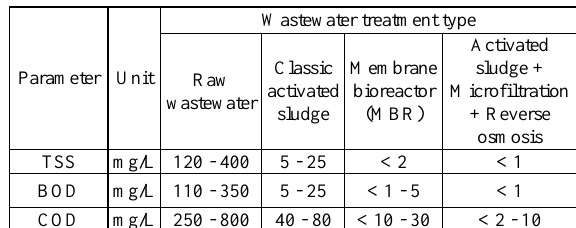
Table 5. Discharge standards in Turkey for different wastewater treatment types